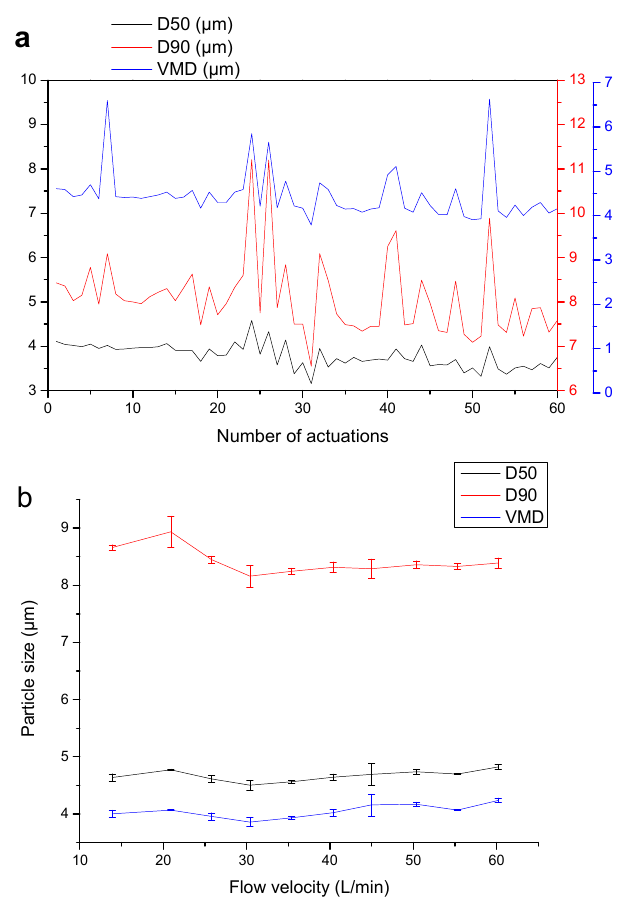
Figure 5. ( a ) Pattern of particle size distribution vs. the number of actuations; and ( b ) pattern of particle size distribution under different flow